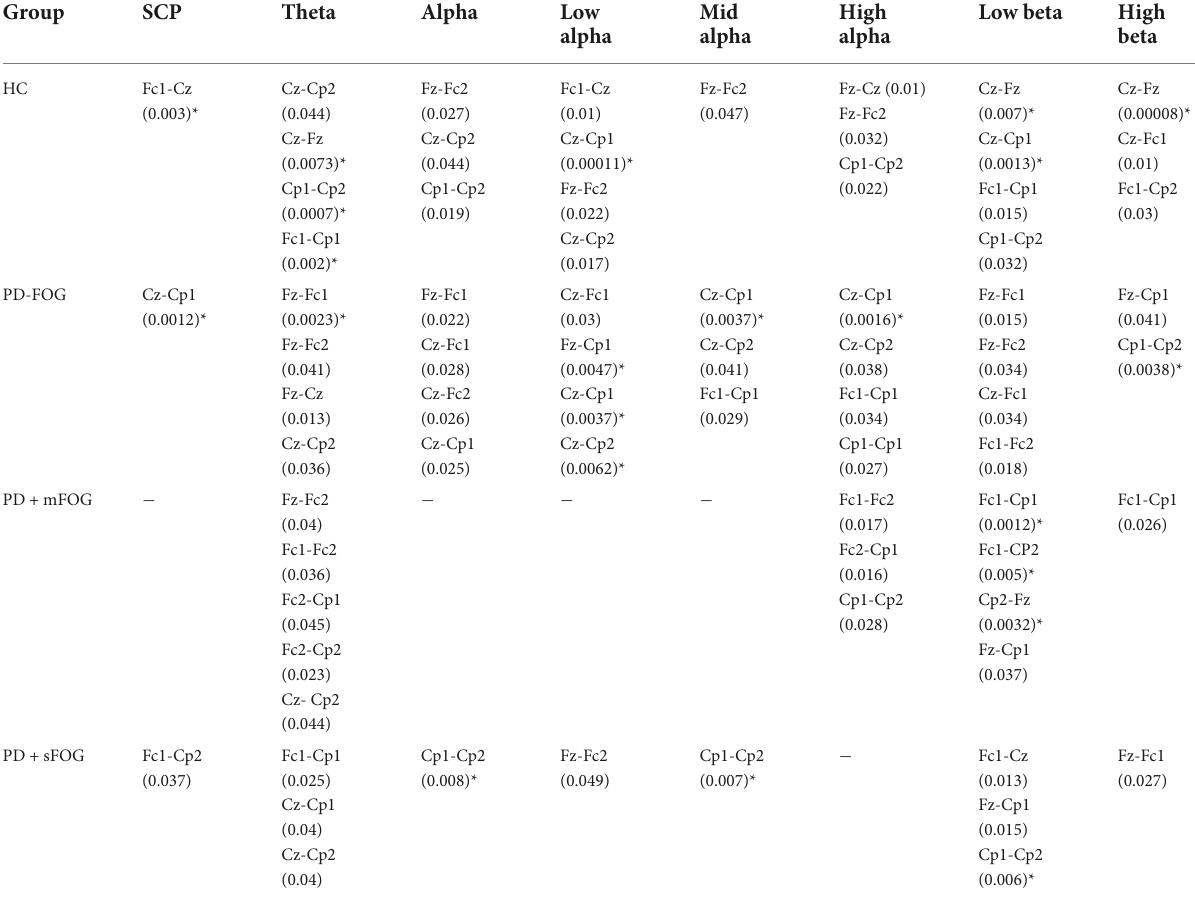
TABLE 2 Pairs of electrodes with significant PLVs over different frequency bands with SL for all groups ( p < 0.05).